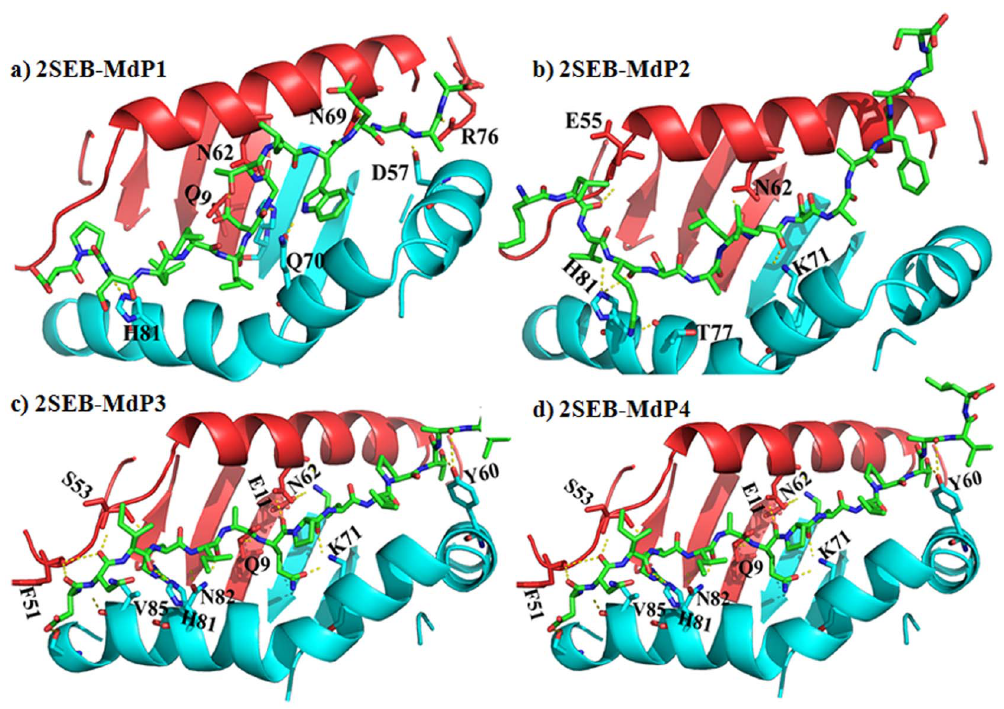
Figure 7. MOMP-derived peptide docking to HLA DR4 MCH II. Cartoon representations of the docked poses of four novel MOMP-derived peptides (MdP1-4, a–d) and the human HLA DR4 MHC II (PDB code 2SEB). The peptides are coloured by element (green carbon; blue nitrogen; red oxygen). a -chains of the MHC II are coloured red, b -chains of the MHC II are coloured cyan. Yellow dashes represent potential hydrogen bonding.